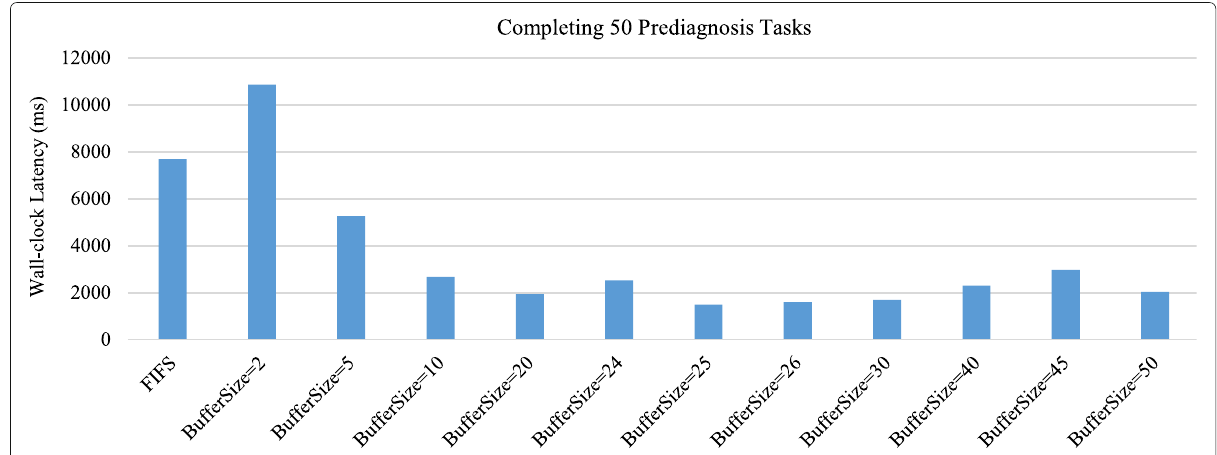
Fig. 10 Wall-clock of latency of completing 50 continuous prediagnosis tasks on our testbed. FIFS indicates the FIFS transmission mechanism, while the others indicate the buffer-aided transmission mechanism with respect to different data sizes